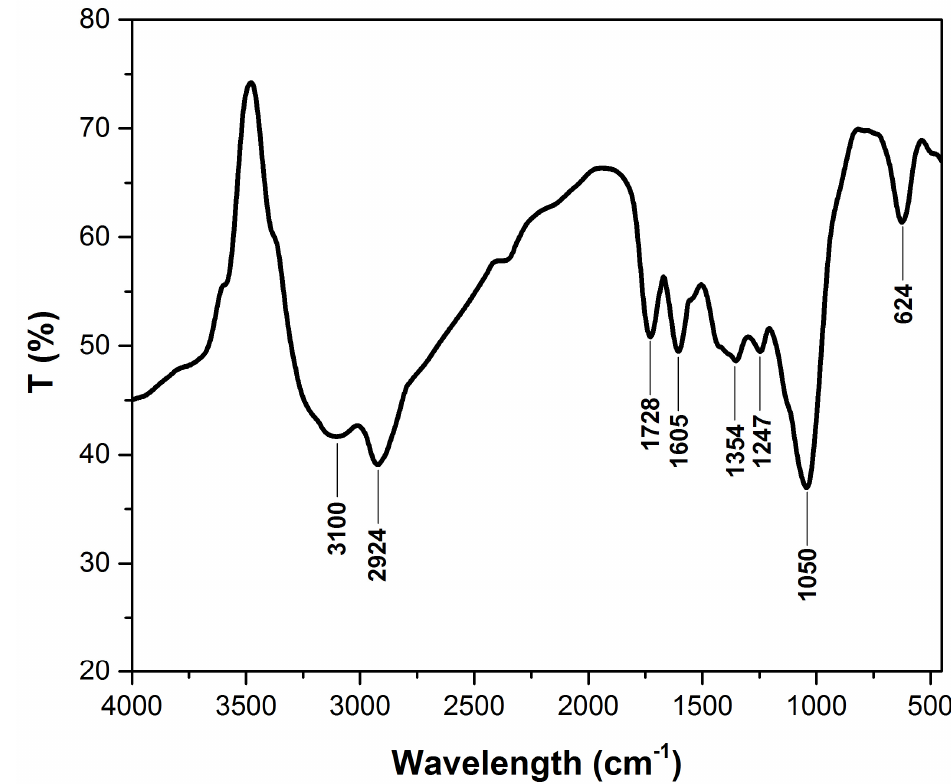
Figure 1. FTIR spectrum of raspberry leaves powder before and after adsorption.